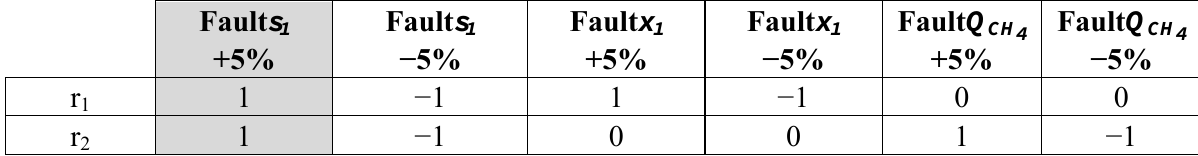
Table 2. Structured Diagnostic